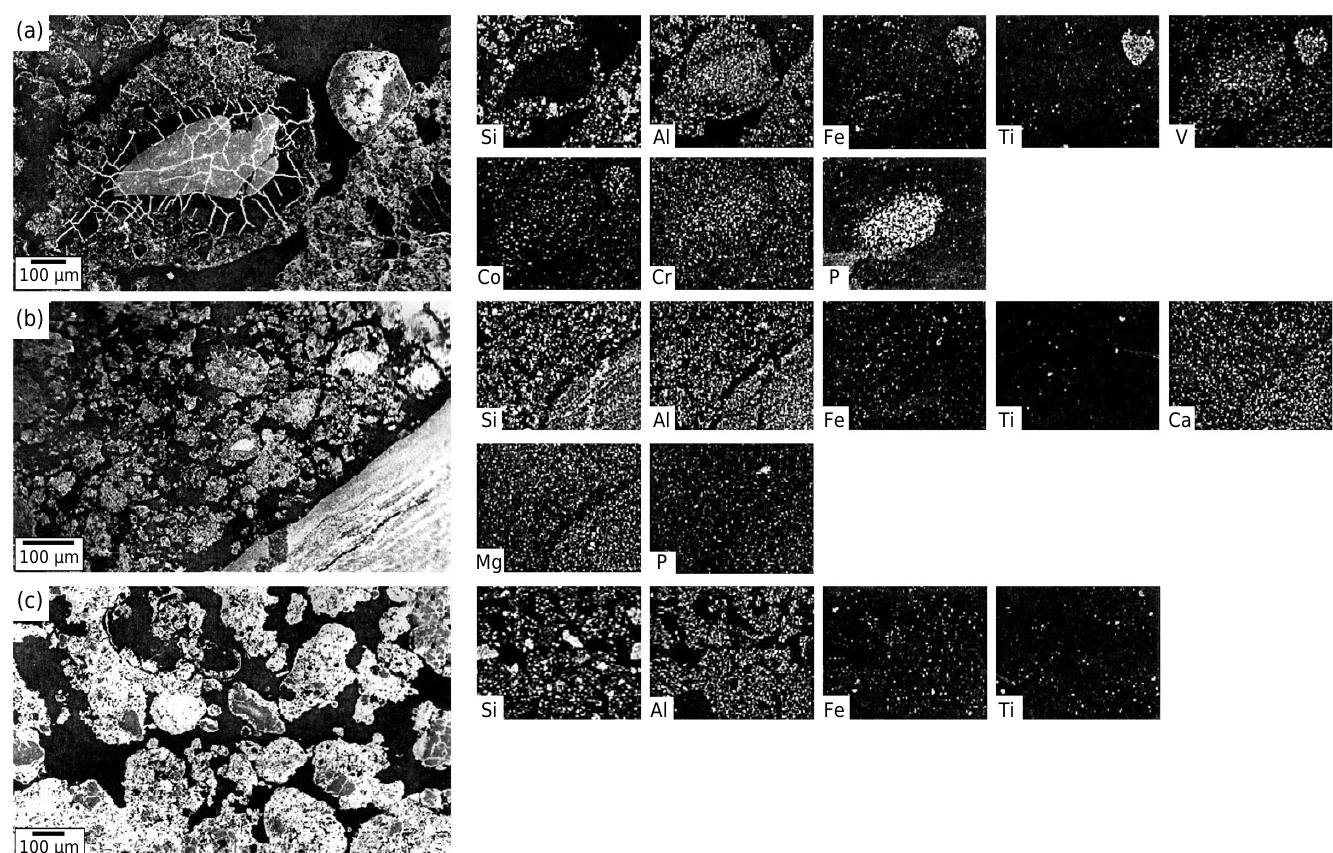
Figure 4. Scanning electron microscope photomicrographs and EDS microchemical maps of the Bi horizon in the P 2 - Eutric Chromic Leptic Cambisol (Humic, Loamic); Serra do Salitre topolithosequence. Degraded apatite grains within microaggregates (a), micro-quartz veins in lithorelict fragments (b), and quartz grains within a well-developed granular structure (c).